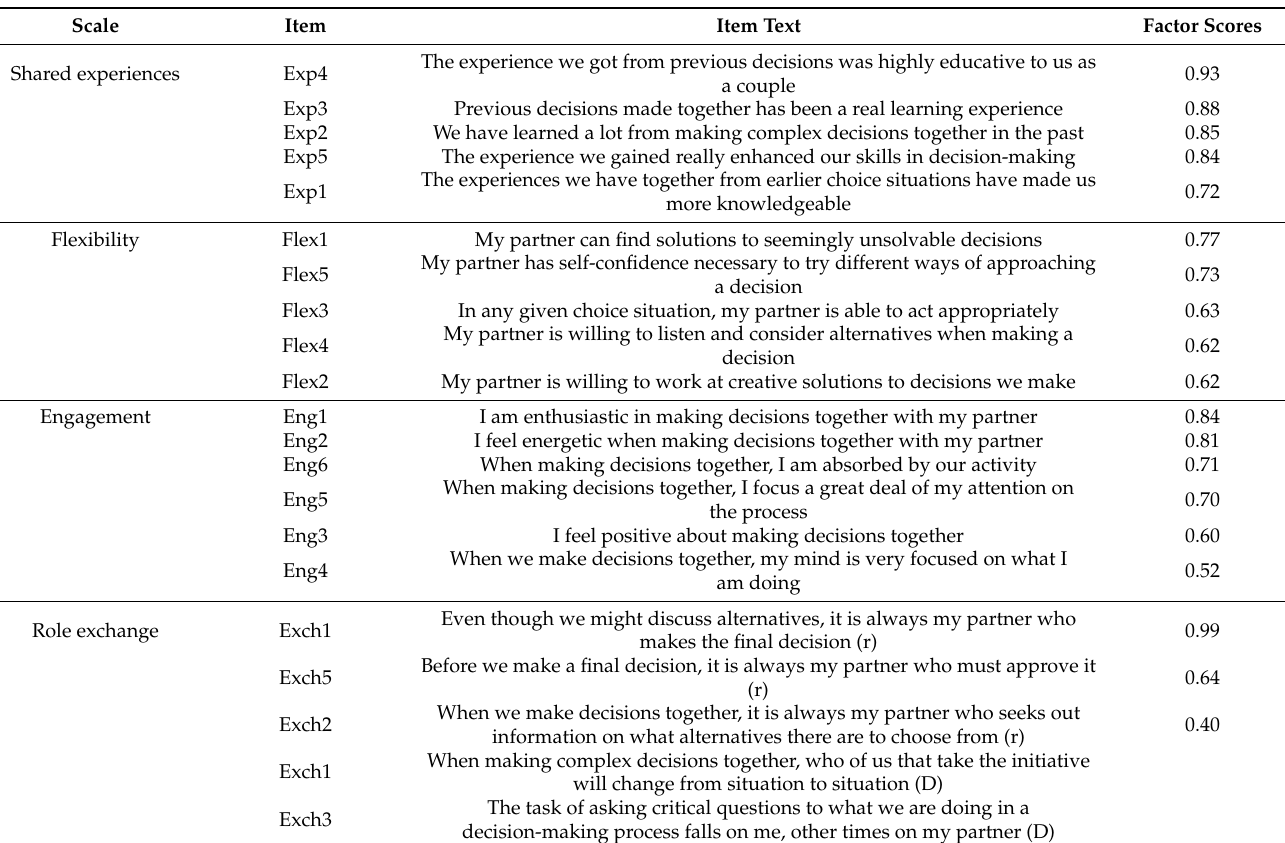
Table 1. Items, factor scores, and reliability for all